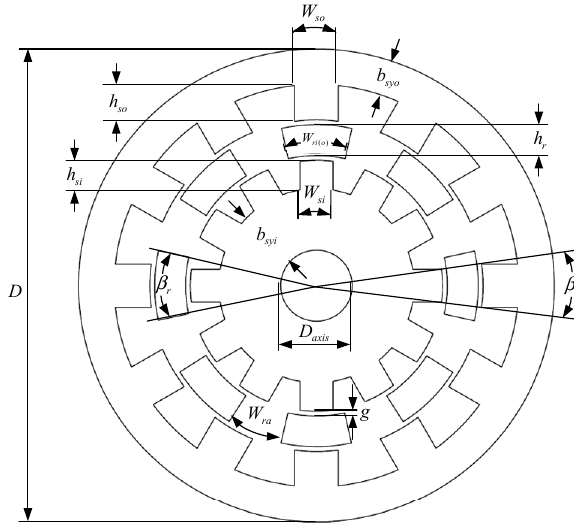
Figure 19. Dimension diagram of the proposed DSSRM.